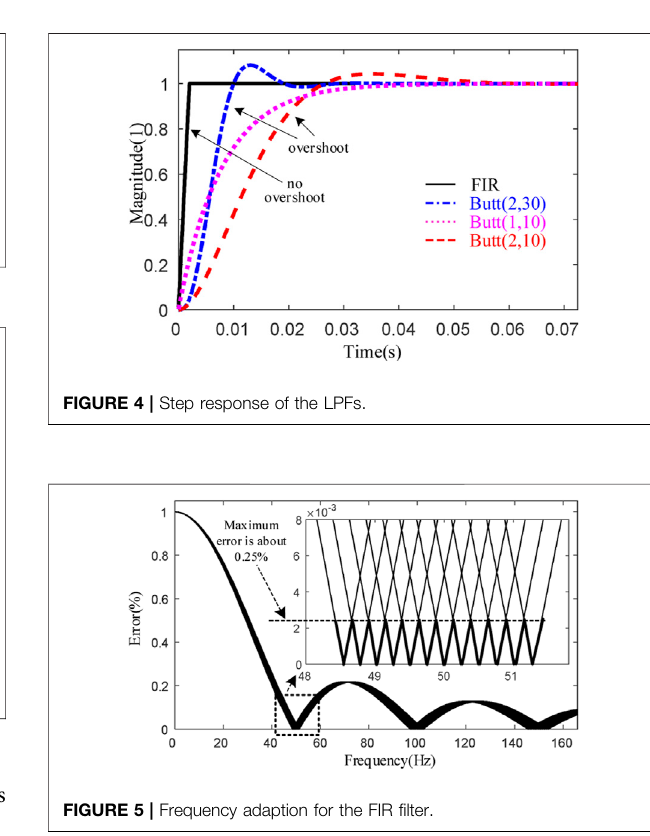
FIGURE 5 | Frequency adaption for the FIR fi